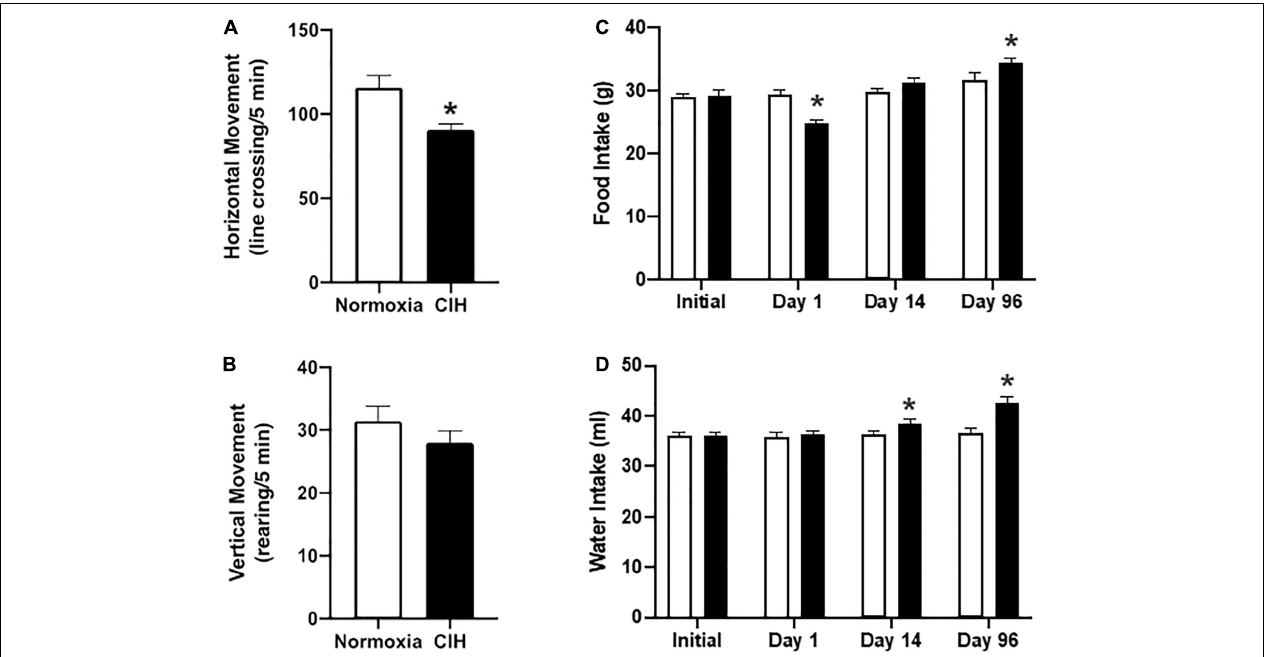
FIGURE 1 | (A,B) Are bar charts showing both horizontal (C) and vertical (D) locomotion after CIH or normoxia exposure. Note that exposure to CIH decreased horizontal movements, although a trend toward decreased rearing was also apparent. n = 8 for each group. (C,D) Are bar charts showing food (C) and water intake (D) . Note that after the first day of CIH exposure there was a decrease in food intake, whereas by day 96, CIH induced an increase in the 24 h food intake (C) . In contrast, by day 14, CIH induced and increase in water intake which was maintained until the end of the study (D) . n = 16 for each group. Data are shown as mean ± standard error. * p <